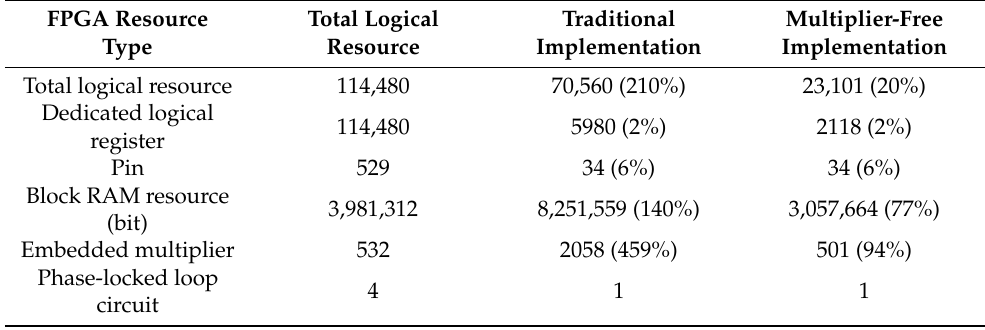
Table 1. List of hardware implementation resource